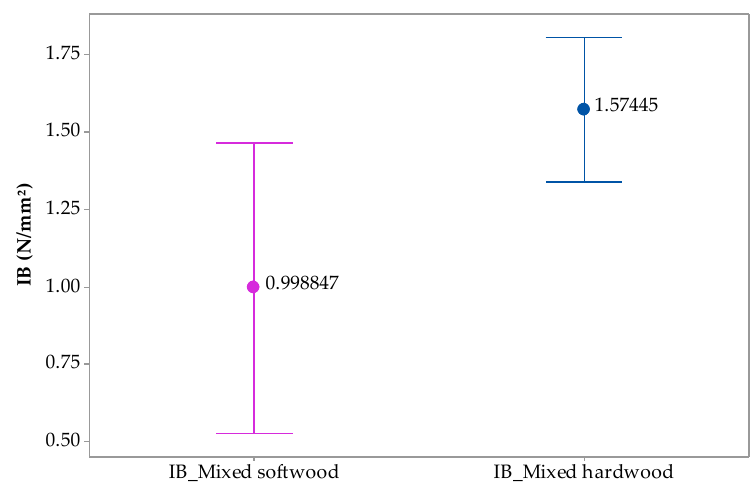
Figure 7. Interval plot of internal bond for the analyzed types of OSBs. Figure 7 . Interval plot of internal bond for the analyzed types of OSBs . Figure 7 . Interval plot of internal bond for the analyzed types of OSBs .